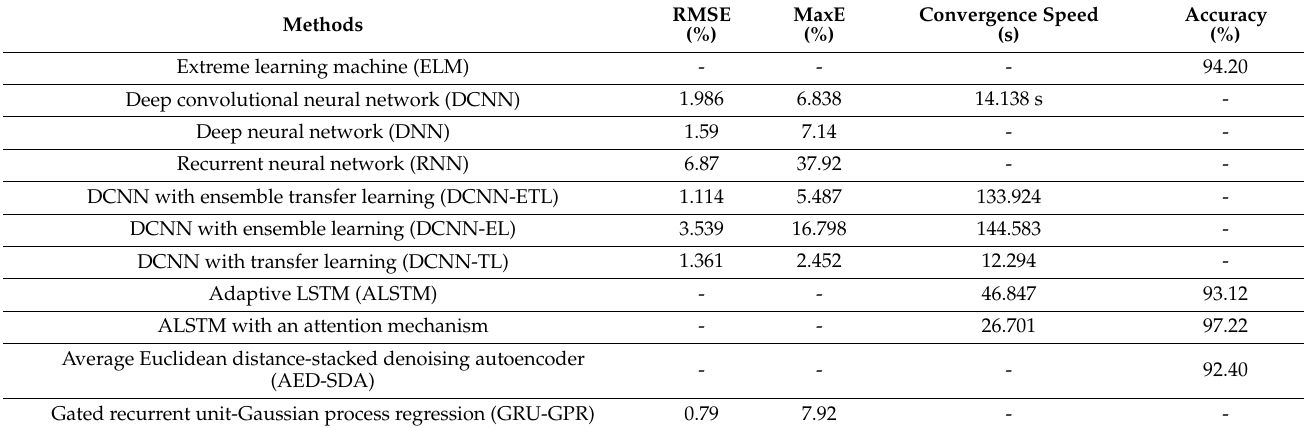
Table 1. The prediction effect comparison results for different DL